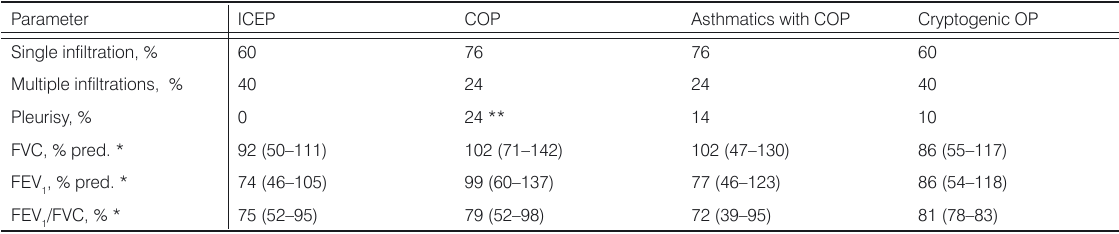
Table 5. Chest X-ray and spirometry tests data of the study patients.